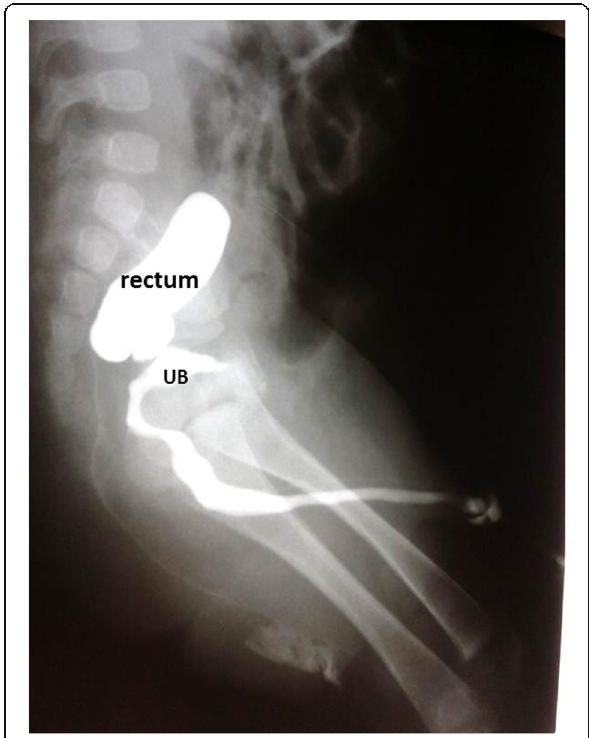
Fig. 10 Recto-vesical fistula in an infant. Voiding cysto-urethrogram showing the rectum could not be separated from the UB